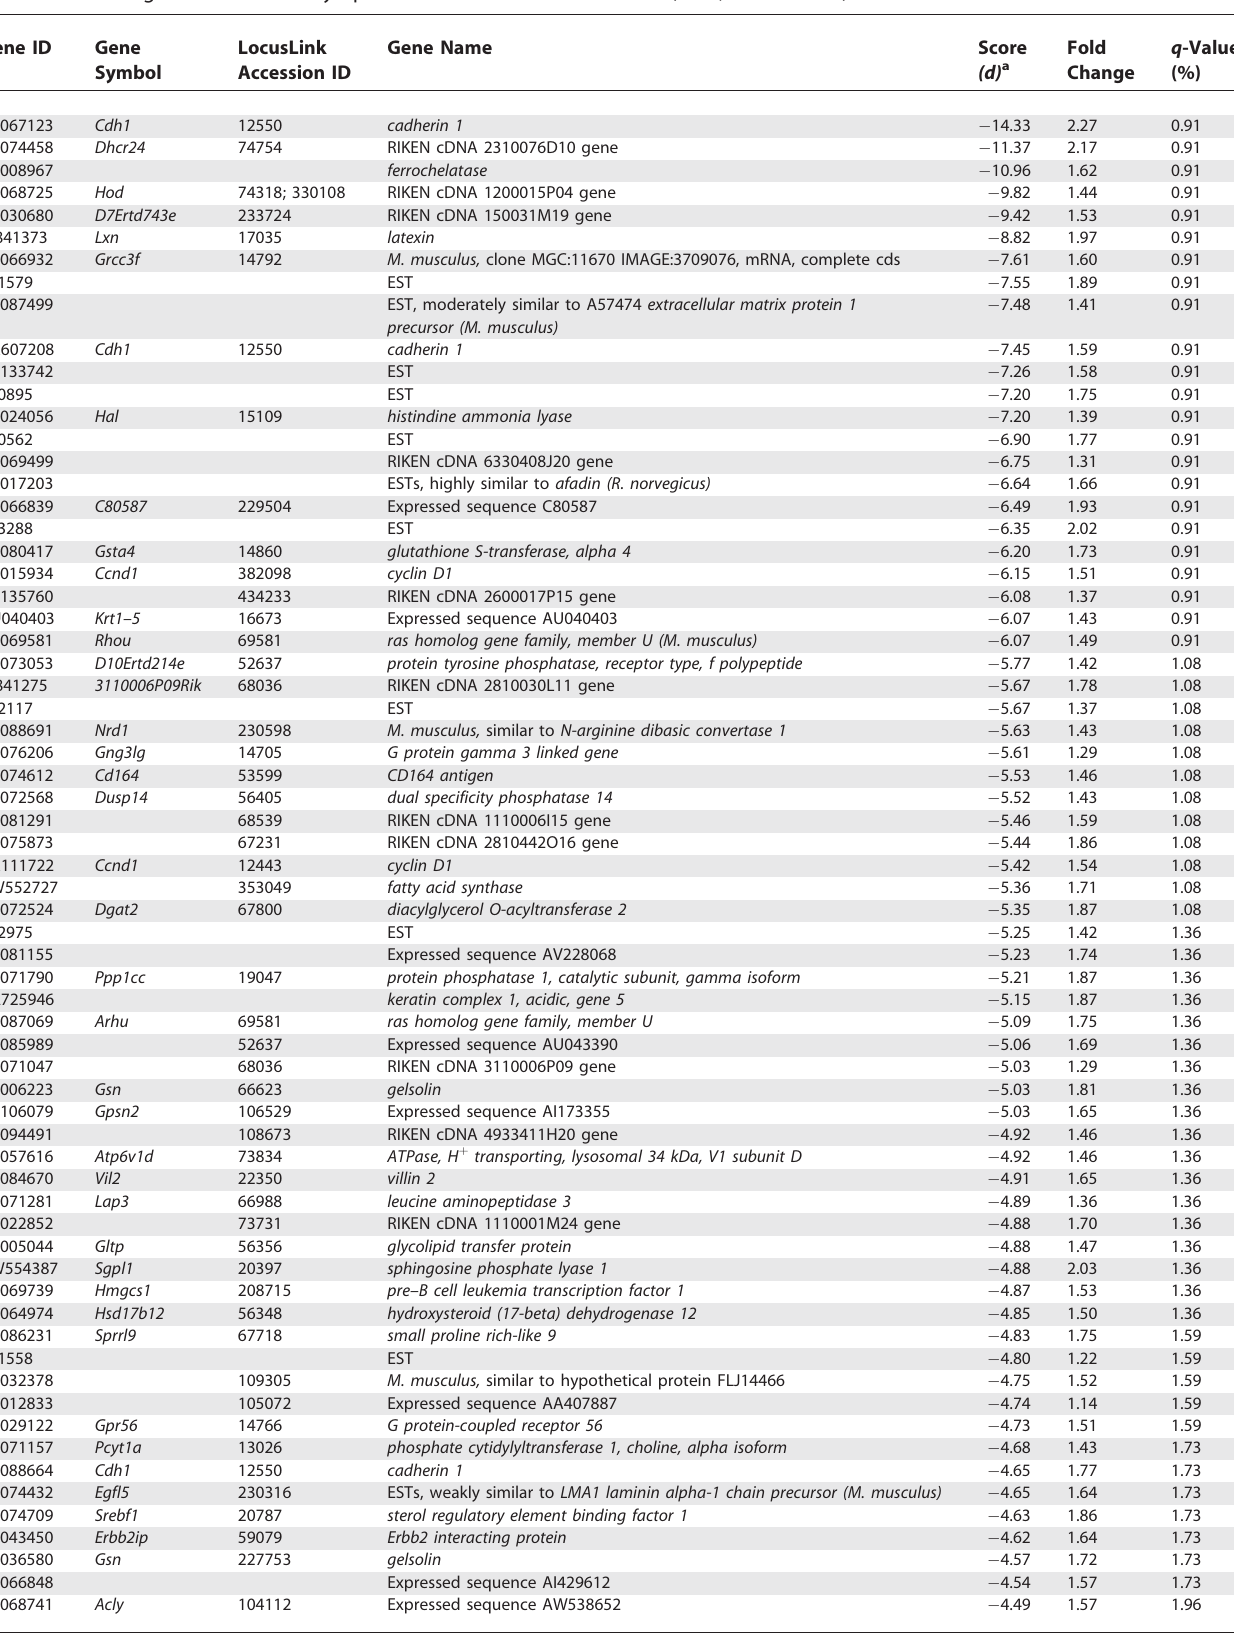
Table 4. Downregulated Genes in Lymphedema versus Normal Control (SAM, FDR , 0.05) Gene ID Gene